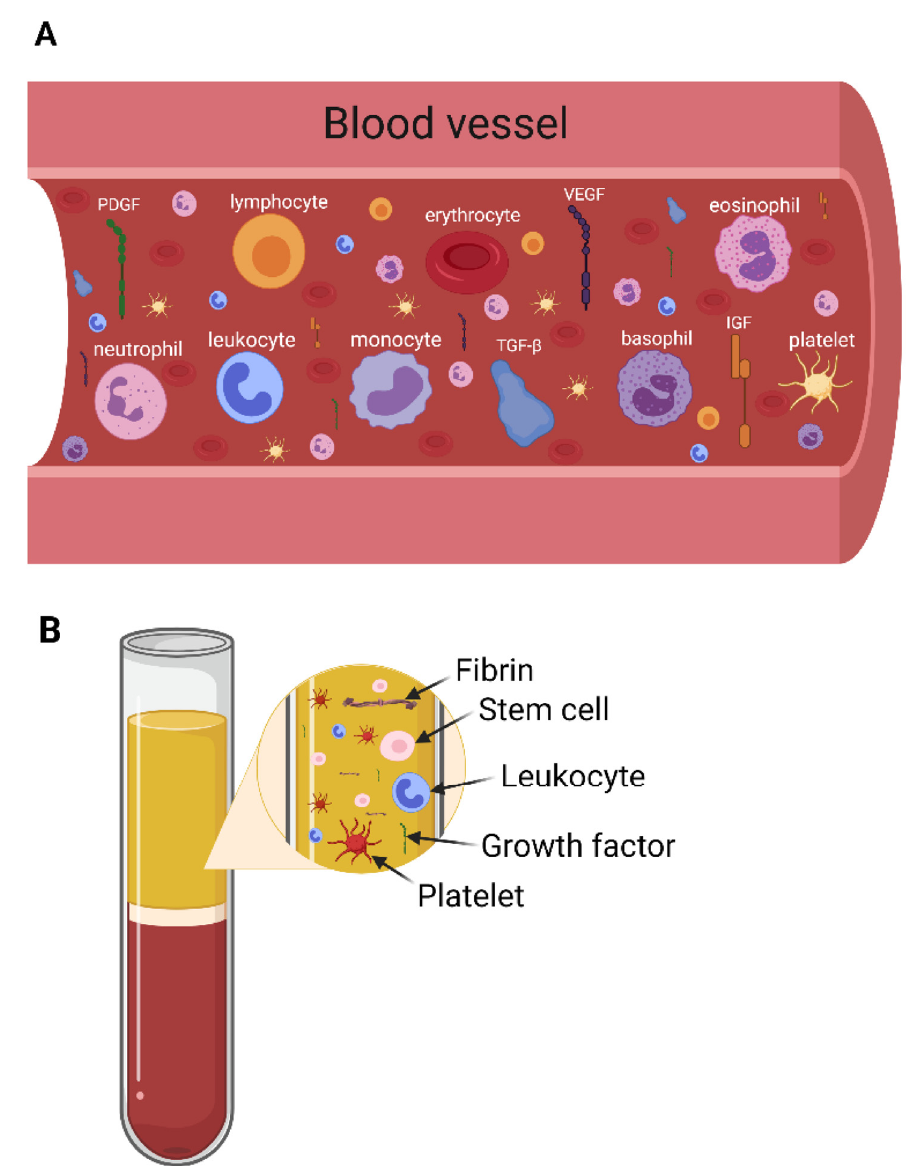
Figure 1. Main elements of blood ( A ) and PRF ( B ). Panel B shows that not all elements in the blood enter the PRF layer after centrifugation. Both figures created with